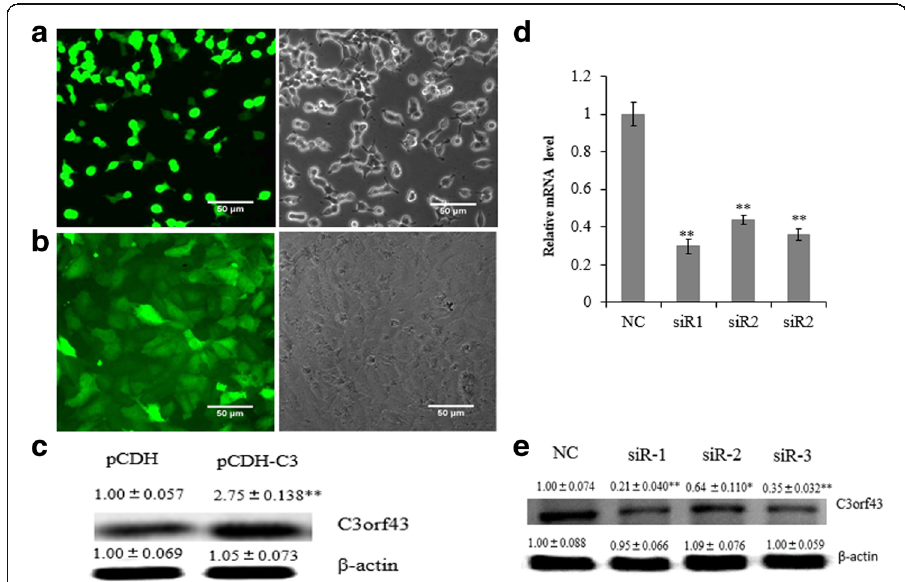
Fig. 2 Preparation of virus and identification of C3orf43 overexpression and knockdown. a 293 T cells transfected with pCDH-C3 were observed with fluorescence microscopy. The bright field is to the left and the fluorescence image is to the right. b BRL-3A cells infected with lentiviral particles were observed with fluorescence microscopy. The bright field is to the left and the fluorescence image is to the right. c The C3orf43 content in the pCDH-C3 group was evaluated via western blot. d and e The expression of C3orf43 was determined using qRT-PCR and western blot. NC, siR1, siR2 and siR3 represent the cells treated with negative siRNA, siR1-C3orf43, siR2-C3orf43 or siR3-C3orf43, respectively. The experiments were performed three times with three replicates in each case. The data are shown as the means ± SD. Representative images are shown. * p < 0.05, ** p < 0.01 difference relative to the